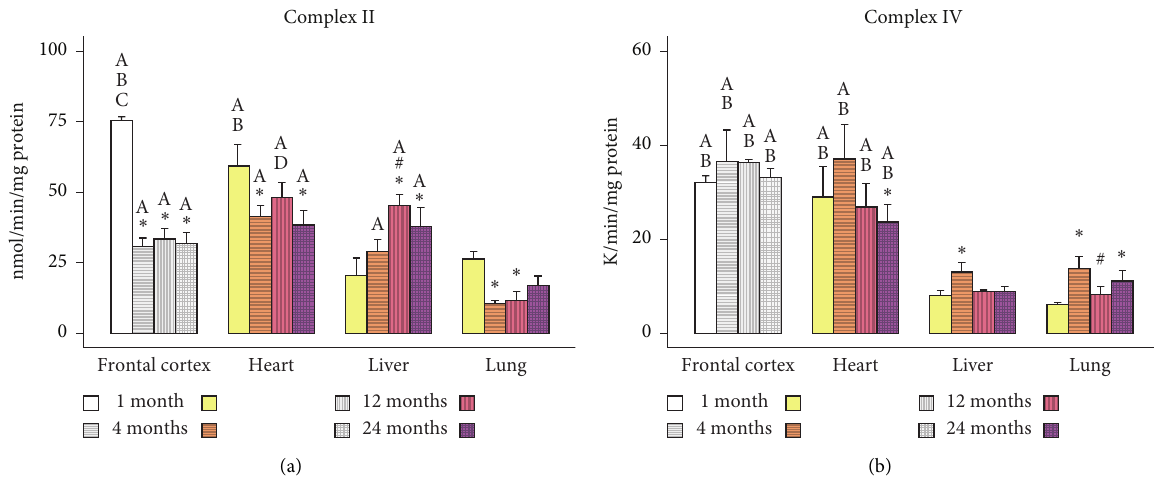
Figure 4: Age-dependent changes in activities of Complex II (a) and Complex IV (b) enzymes in different organs. Values are expressed as means ± SEM from n � 5 observations/group. The differences between pairwise comparisons were considered statistically significant at p < 0 . 05. ∗ Significantly different from 1M rats; # significantly different from 4M rats; A significantly different from lung; B significantly different from liver; C significantly different from heart; D significantly different from frontal cortex; SEM, standard error of the mean. Grey- scale bars represent frontal cortex data from our previous report (adapted from Pandya et al. [23], with